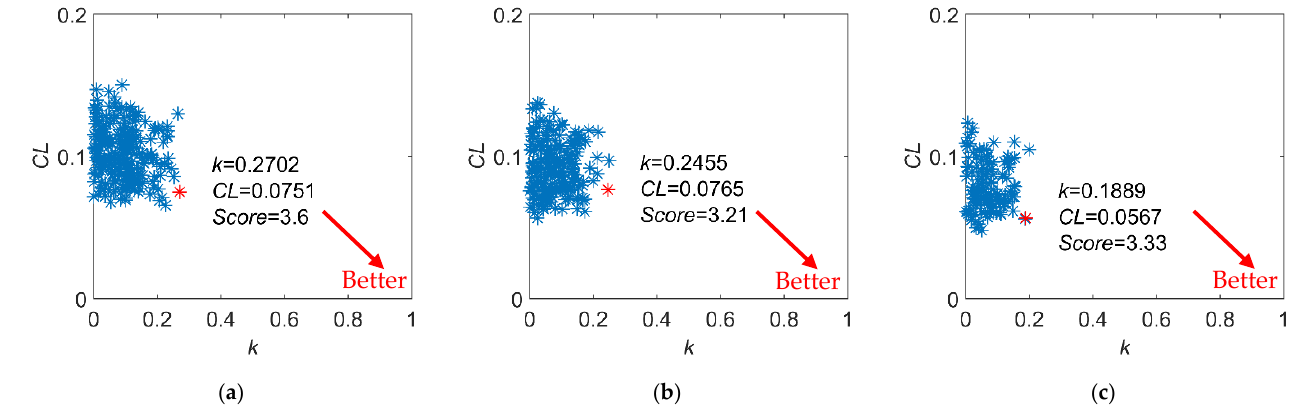
Figure 13. The evaluation results of traversing different number of indices: ( a – c ) are the results of p = 5, 6, 7, respectively, k is the independence coefficient, and CL is the comprehensive loss rate of the contribution rate. ( a ) p = 5. ( b ) p = 6. ( c ) p = 7. Table 9. Comparison results of different index